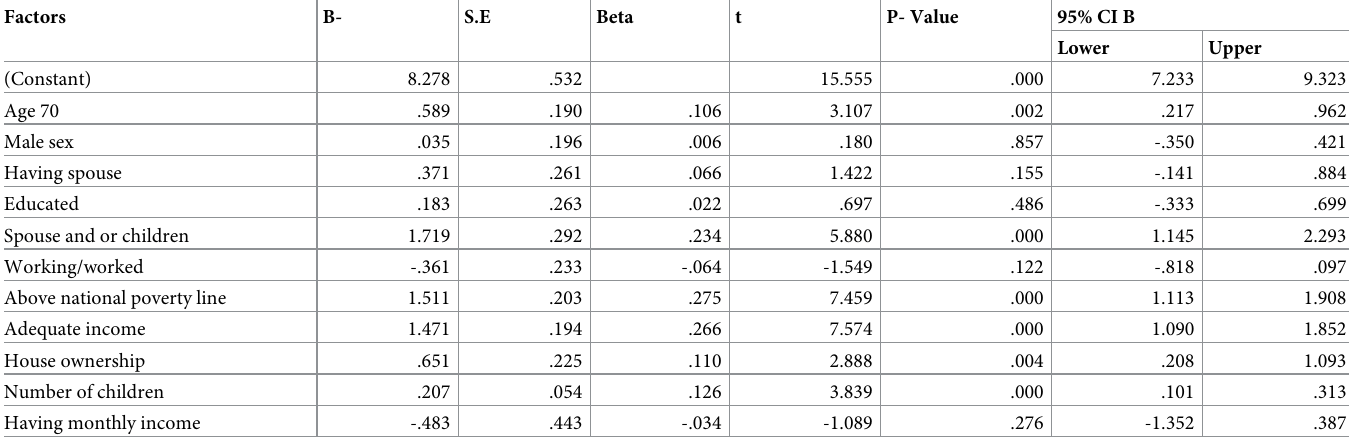
Table 4. Contributing factors of psychological domain of the QOL of participants.